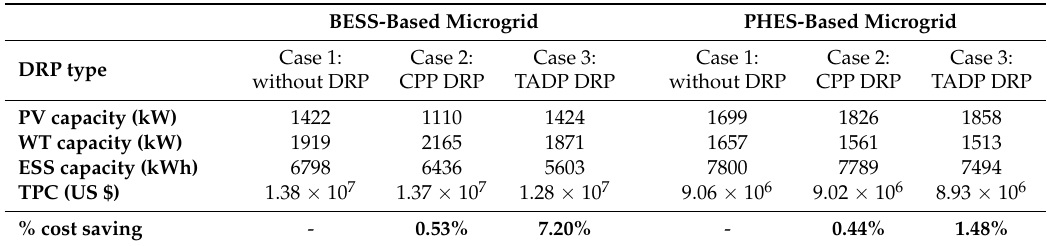
Table 7. Techno-economic analysis for each ESS type based on the DRP flexibility